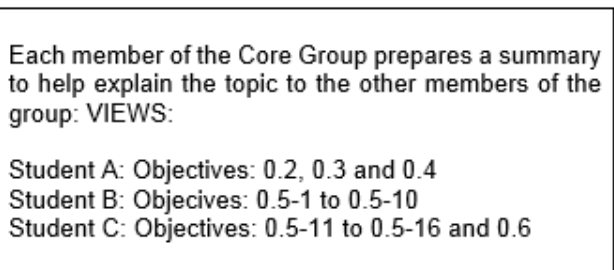
Figure 1. Specific objectives for each student in session